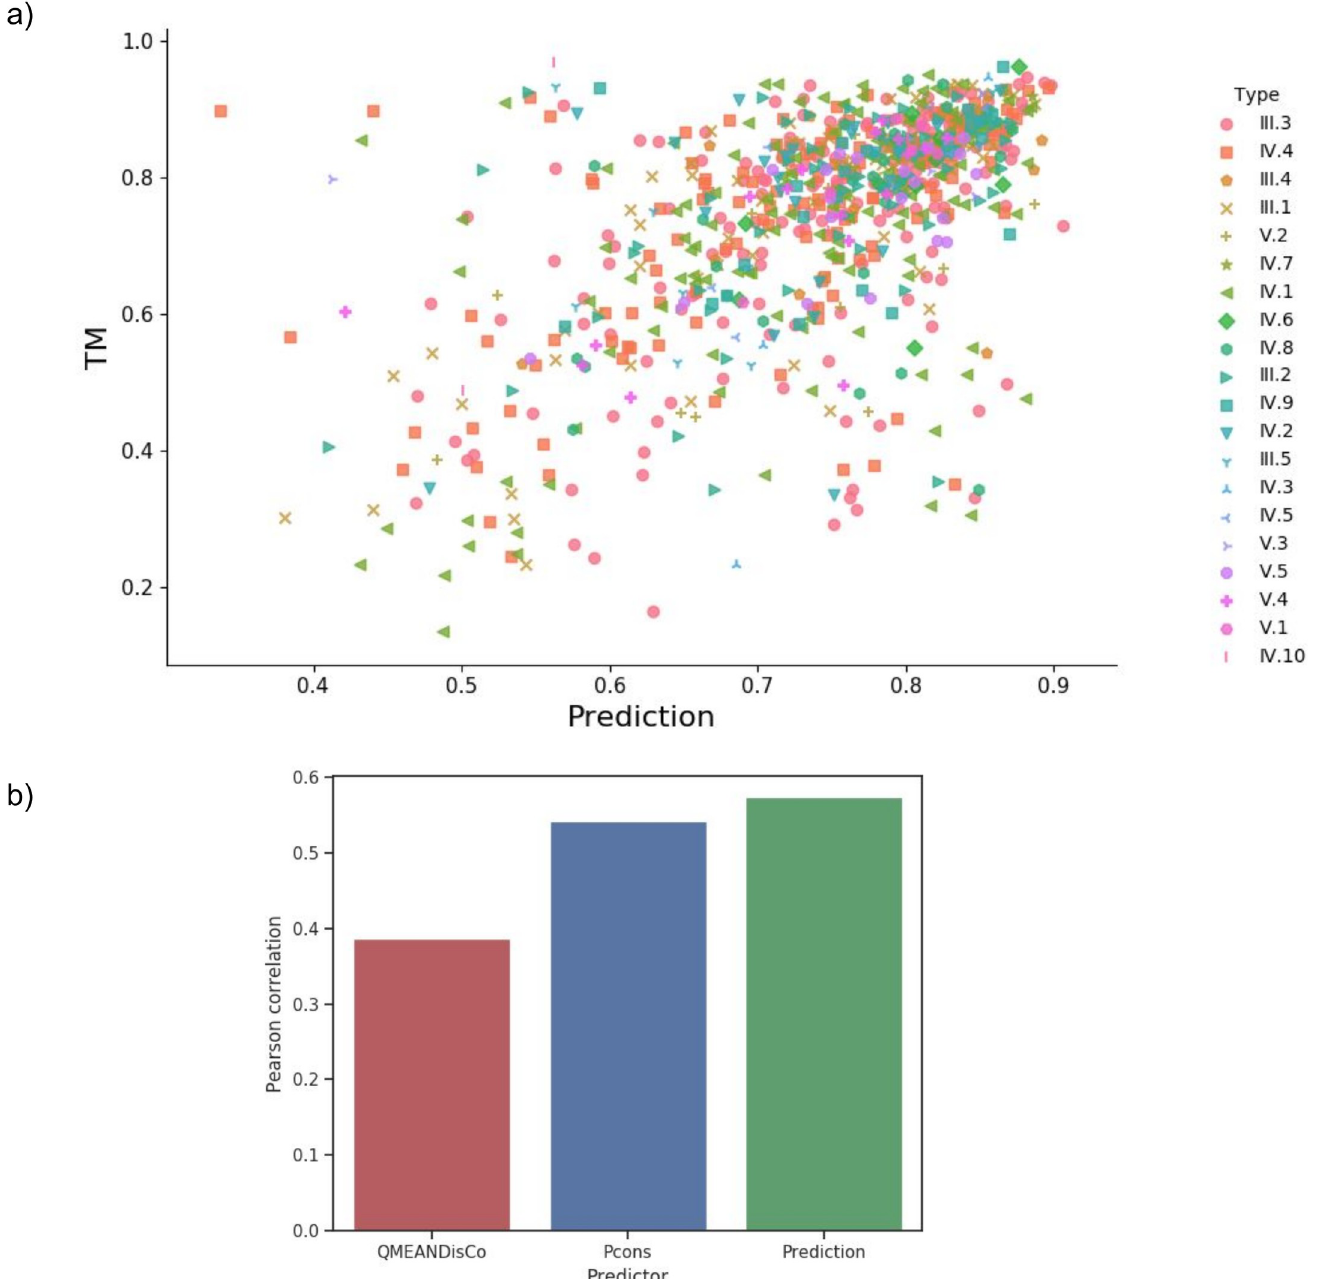
Fig 9. a) Real TM-score versus Random Forest Predicted TM-score for complete region models generated with trRosetta. b) Pearson correlation coefficient between the TM-score and the QA